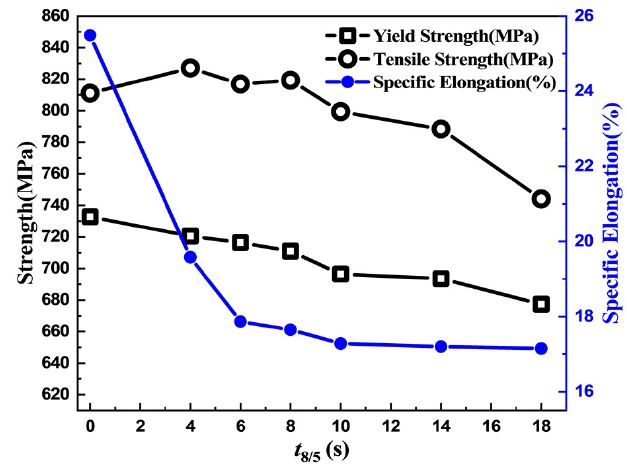
◦ C at different t 8/5